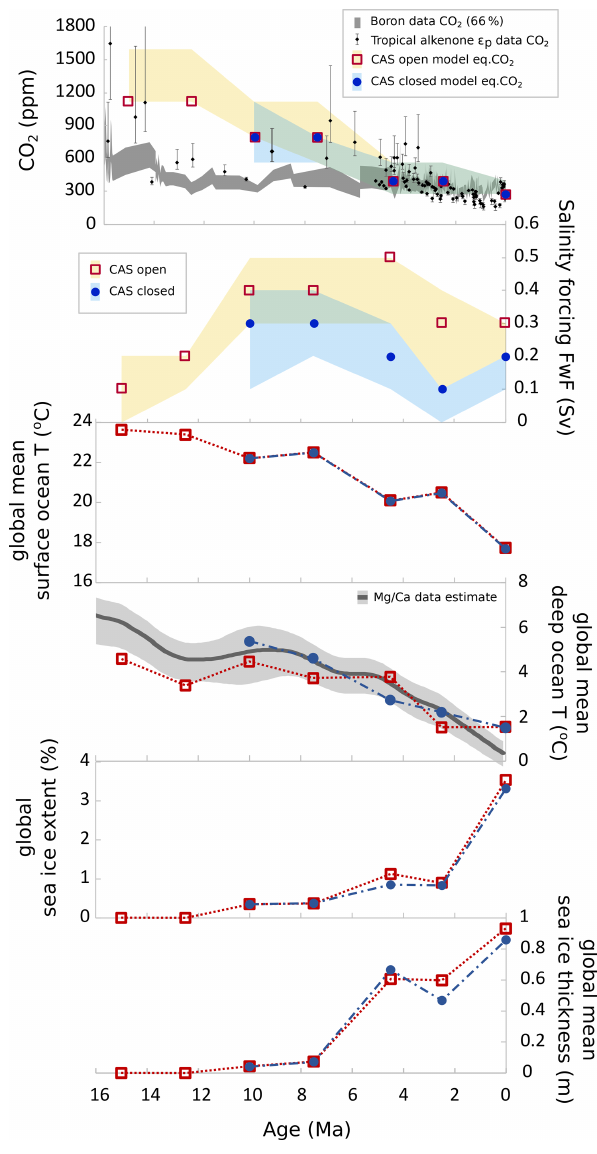
Figure 7. The eq.CO 2 and FwF settings (and estimated ranges) that agree with temperature and benthic δ 13 C data constraints accord- ing to this study. Plotted with eq.CO 2 are estimates for atmospheric CO 2 levels from two recent studies on tropical alkenones (Stoll et al., 2019) and boron (Sosdian et al., 2018). Also shown are modelled global mean surface ocean temperature, global mean benthic ocean temperature (and the Mg / Ca thermometer estimate from Cramer et al., 2011), modelled global sea-ice extent, and modelled global mean sea-ice thickness for the best fit settings.